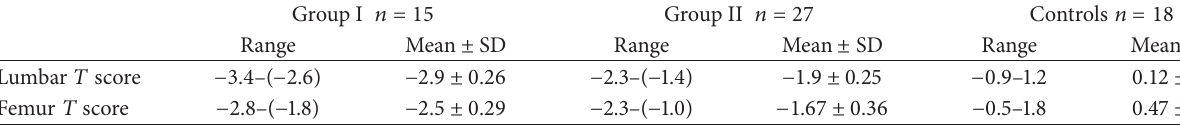
Table 3: DXA results in group I, group II, and controls.